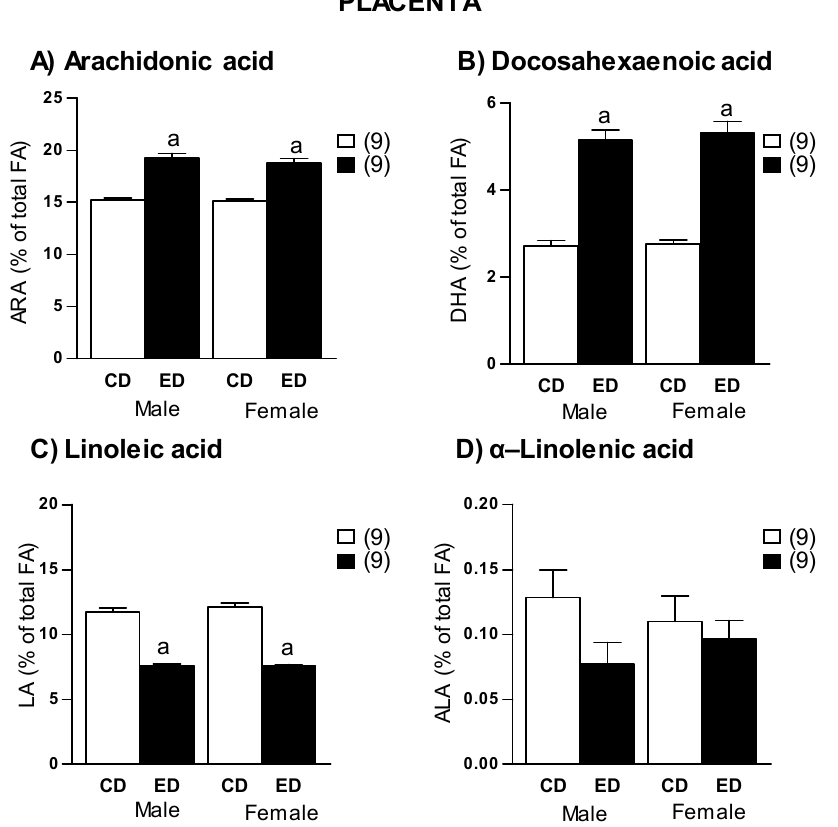
Figure 4. Placental levels of ( A ) Arachidonic acid (ARA), ( B ) docosahexaenoic acid (DHA), ( C ) linoleic acid (LA), and ( D ) α -Linolenic acid (ALA) in dams fed with control diet (CD) and experimental diet (ED), separated by sex. Data show mean ± SEM. Between parenthesis, the litter sample size is shown (from each litter 2–3 placentas of each sex were averaged). Student’s t test. a p < 0.001 ED versus CD.